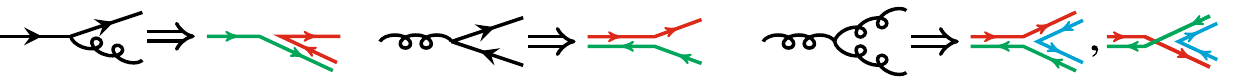
Fig. 1 QCD colour propagation rules for elementary quark–gluon vertices. Black lines denote Feynman-diagram style vertices, coloured lines show QCD colour connection lines